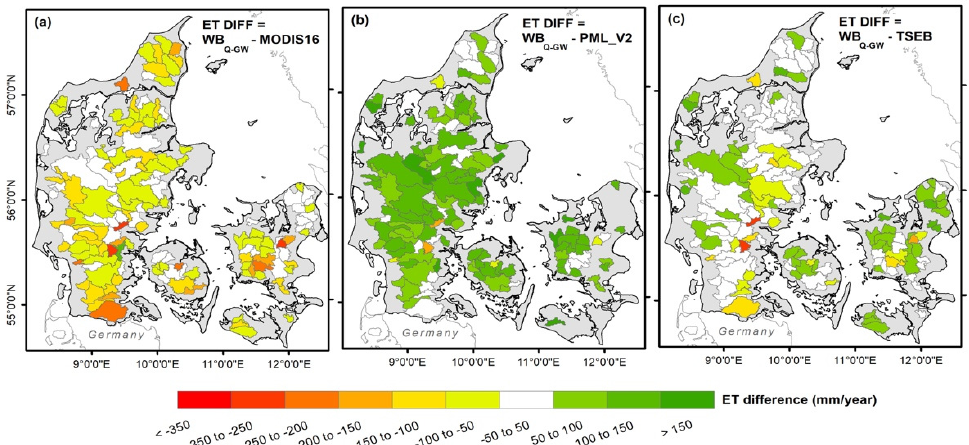
Figure 8. Maps of the differences between the sub-catchment ET (mm/year) from the modified water balance method (WB Q-GW ), and the remote-sensing models of MODIS16 ( a ), PML_V2 ( b ), and TSEB ( c ).